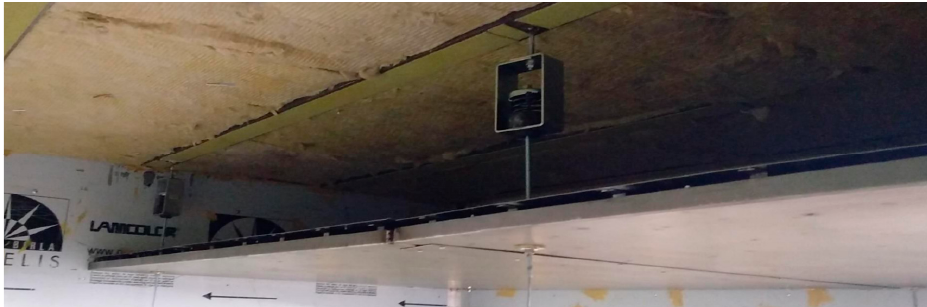
Figure 12. Deck covering mock-up with the 450 mm air-gap configuration.